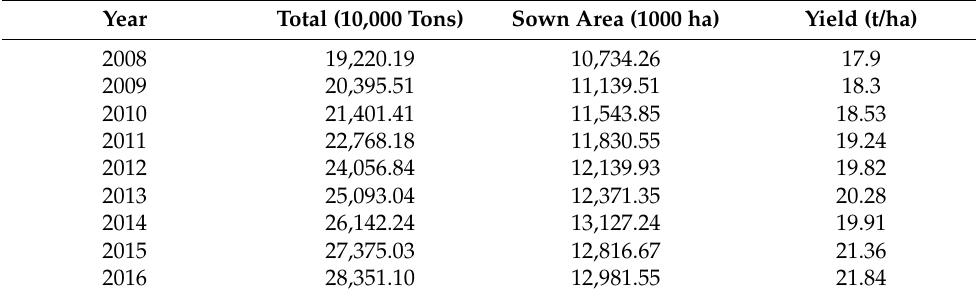
Table 1. The annual fruit yield and planting area data for the calendar year in China. Year